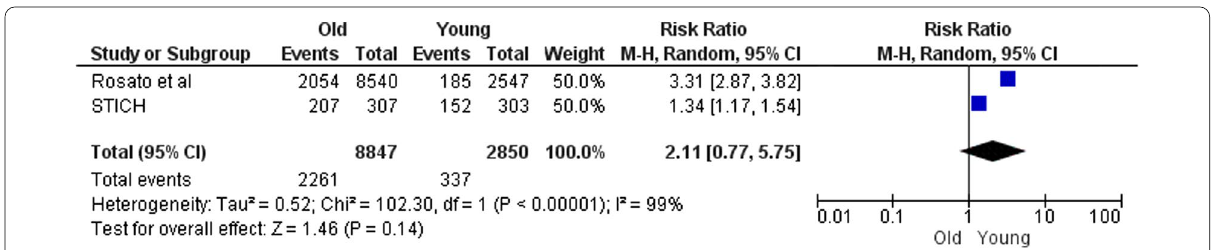
Fig. 6 Death after CABG in old versus young